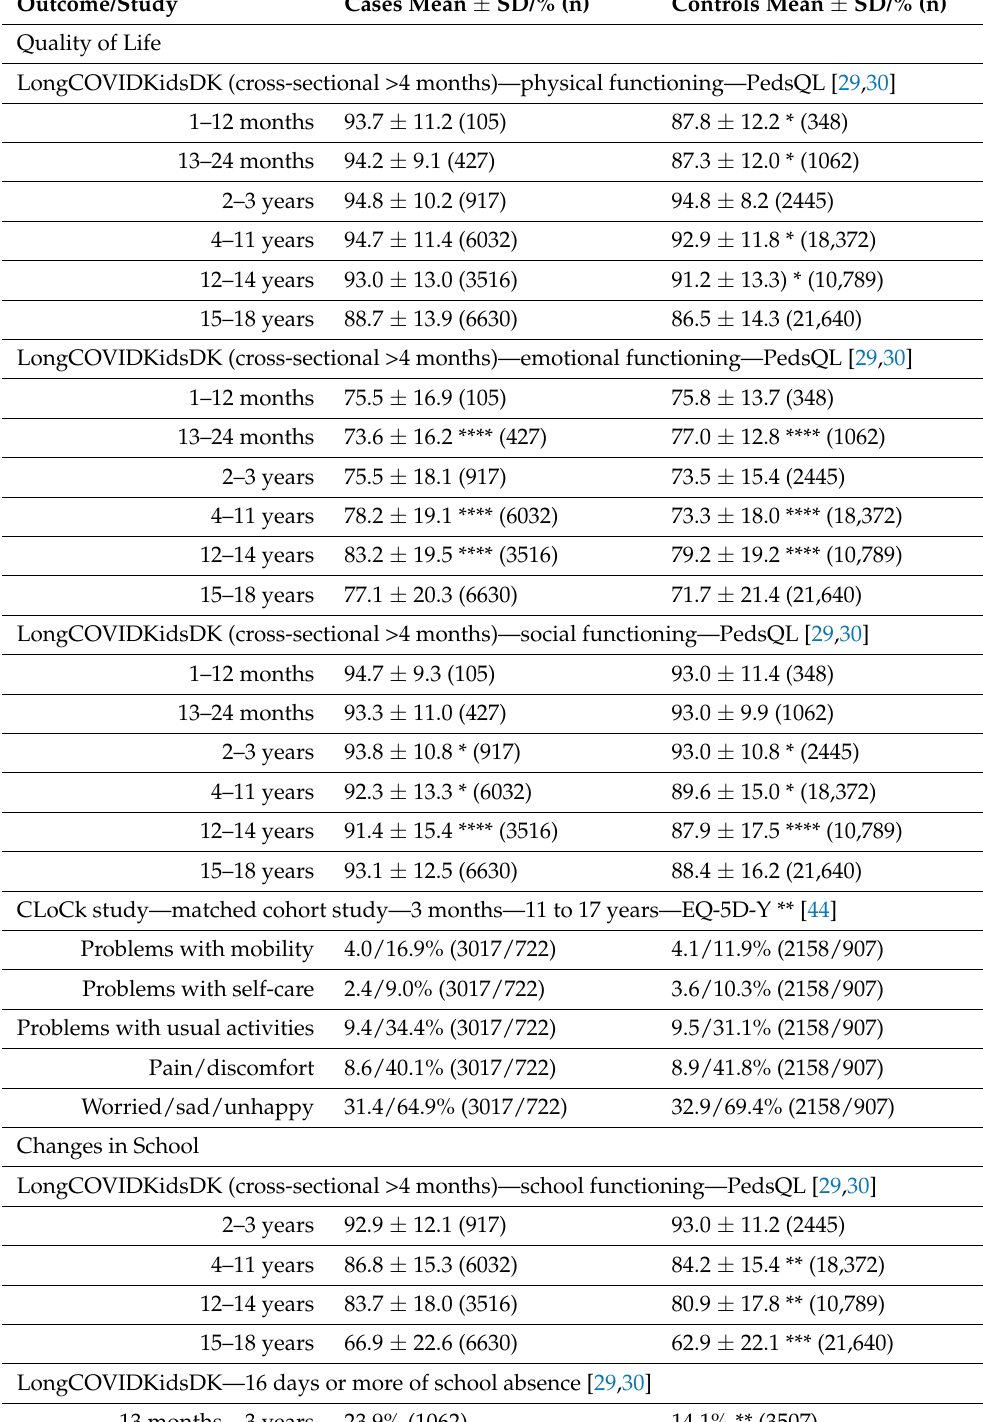
Table 2. Summary of the findings from the main large controlled